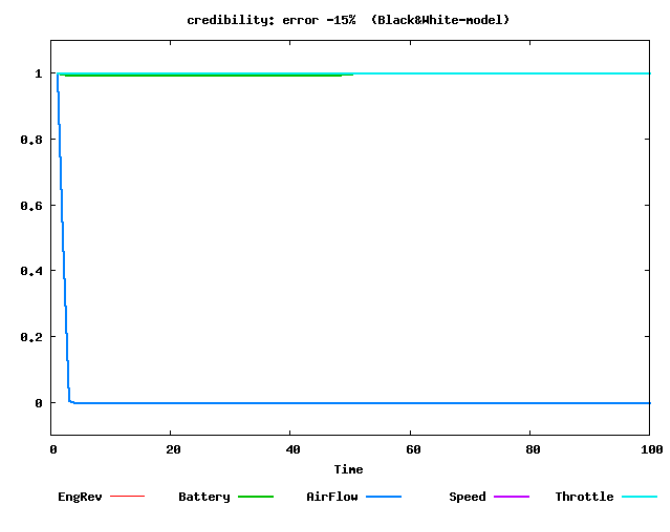
Figure 3. Diagnosis using profiles (parameters and thresholds) calculated from the VAR model when the air flow sensor is faulty. The plotted line shows the time evolution of credibility for the sensor; only the credibility of the faulty sensor becomes 0, hence the diagnosis is successful [6]. © 2006